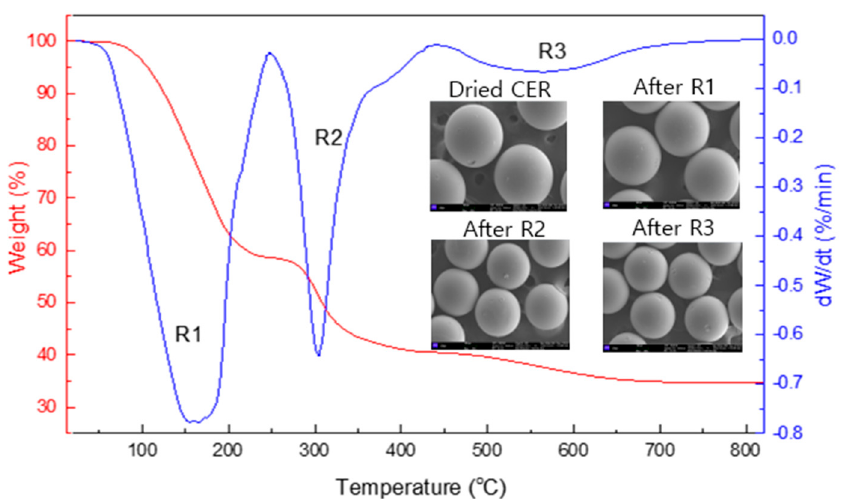
Figure 3. Changes of the sample weight (TG) and derivative of the samples weight (dTG) at ele- vated temperatures, and SEM image of dried sample and those after the R1, R2, and R3 reaction